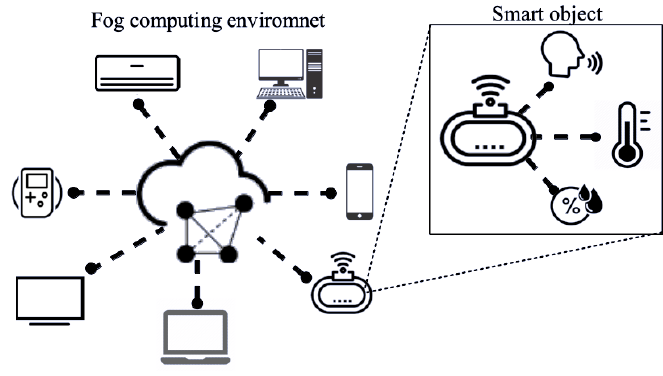
Figure 2. Overview of the fog environment and its respective nodes.